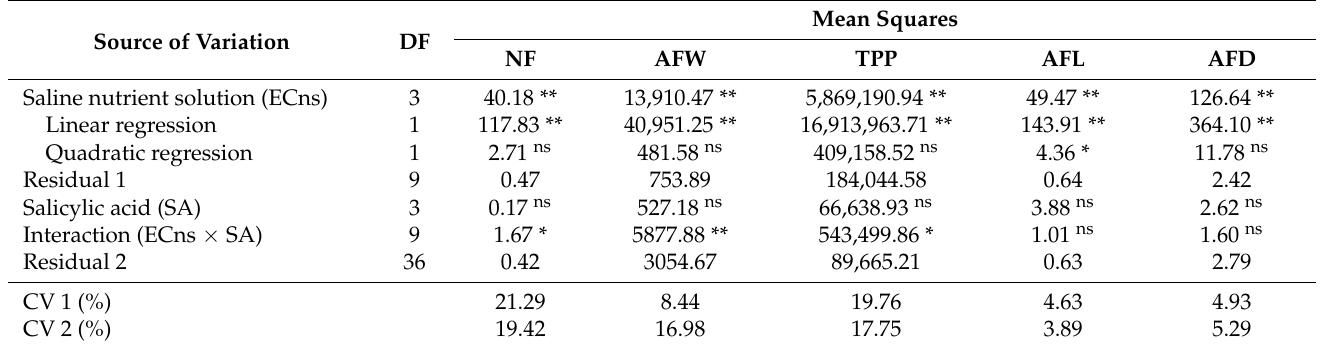
Table 5. Summary of the analysis of variance (ANOVA) for the number of fruits (NF), average fruit weight (AFW), total production per plant (TPP), average fruit length (AFL), and average fruit di- ameter (AFD) of Japanese cucumber grown in a hydroponic system with saline nutrient solution and foliar application of salicylic acid, 45 days after transplanting.